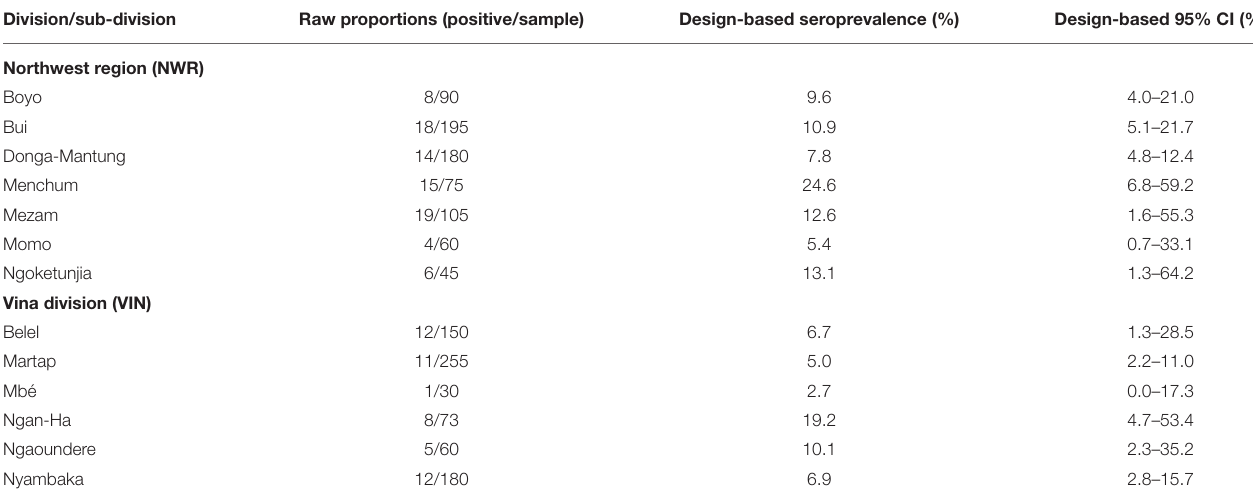
TABLE 1 | Design-based animal-level seroprevalence (not adjusted for test performance) of RVF antibodies in cattle in two sites in Cameroon in 2013 stratified by Division (NWR) and sub-Division (VIN). Division/sub-division Raw proportions